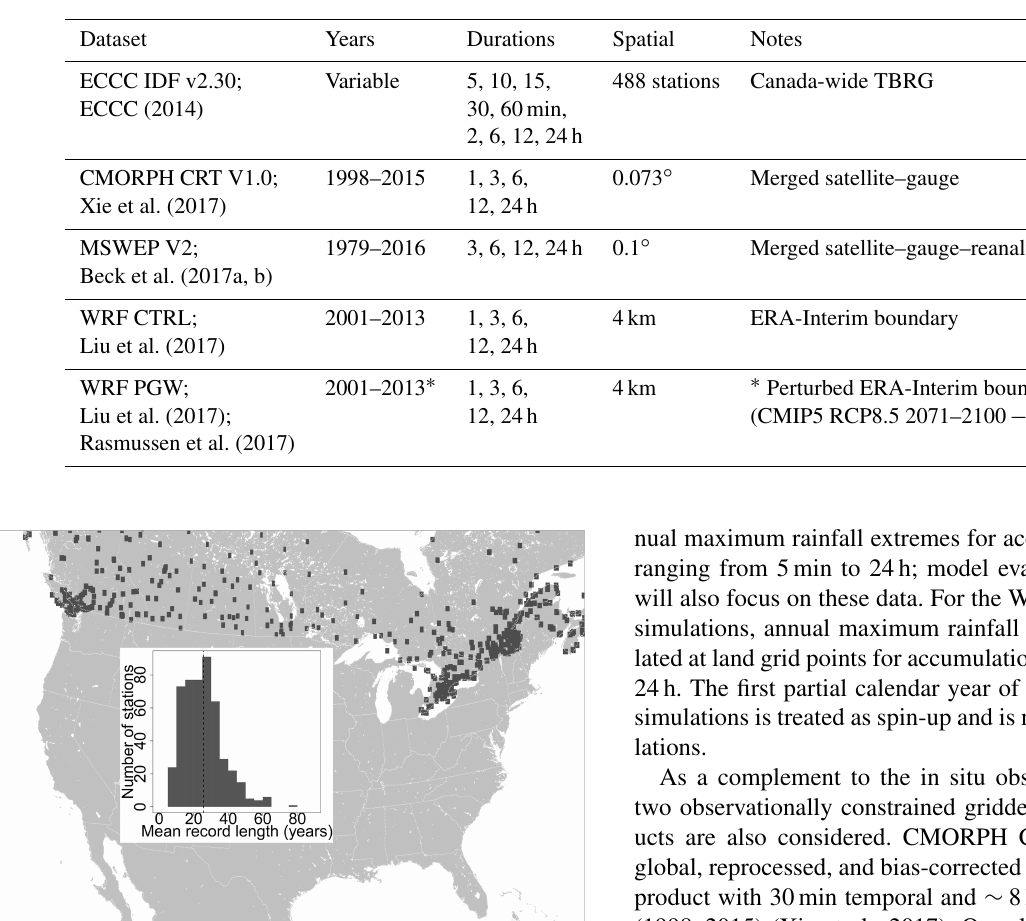
Table 1. Summary of observational data and climate model simulations used in the study.